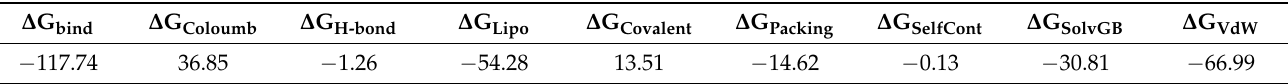
Figure 6. ( A ) Docking pose of t-H 2 Pagg with the lowest ∆ G bind into the 1B subdomain of HSA (PDB ID 1N5U). The protein surface is colored according to the electrostatic potential, while t-H 2 Pagg is shown as cyan CPK. ( B ) Close view of the binding mode of t-H 2 Pagg into HSA. t-H 2 Pagg is represented as cyan sticks, while the residues of HSA involved in the interactions are displayed as grey sticks. H-bonds are shown as yellow dashed lines, while π -stacking and π -cation interactions are represented as cyan and green dashed lines, respectively. Table 1. Binding free energy ( ∆ G bind ) and individual energy terms, expressed in kcal/mol, of the t-H 2 Pagg–HSA